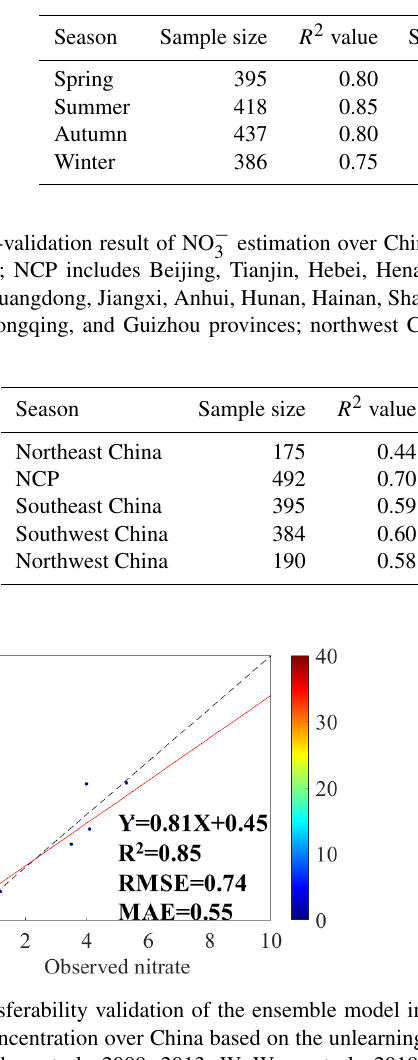
− estimation over China in four seasons. 3